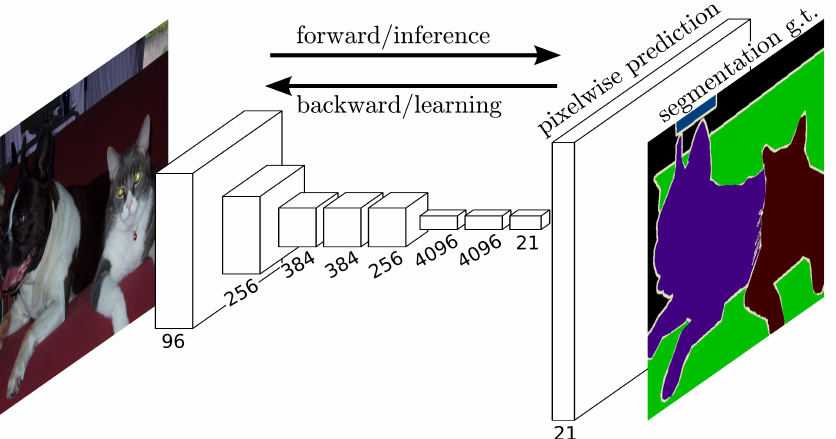
Figure 9. Explained architecture of Fully Convolutional Neural Network. Image is obtained from